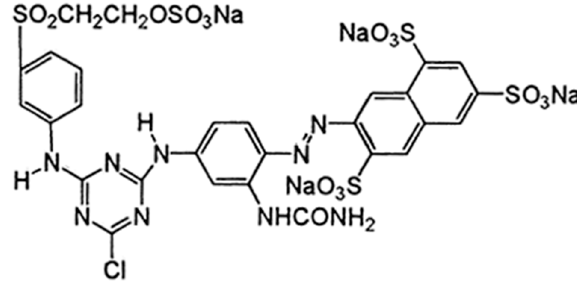
Figure 2. Chemical Structure of RY 145 [28–30].